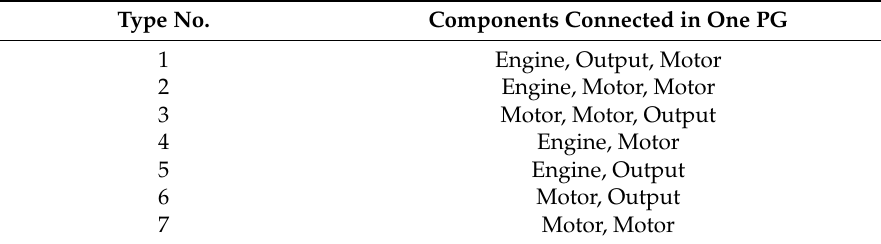
Table 2. Types of feasible connections in one planetary gear (PG) of a configuration. Type